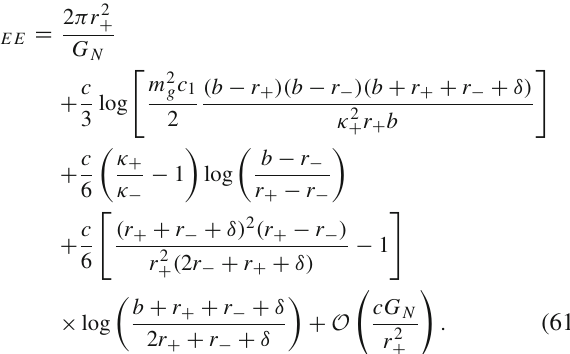
Fig. 6 The Penrose diagram of the eternal non-extremal charged black hole in massive gravity with the no island configuration (left panel) and the island configuration (right panel). The radiation region is the union